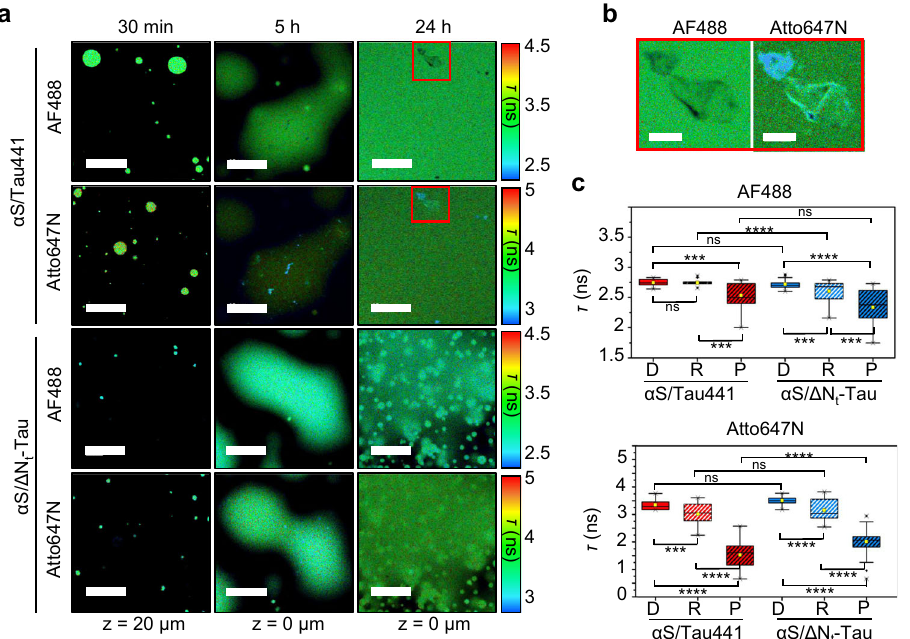
Fig. 6 | Analysis of the liquid-to-solid phase transition of α S/Tau coacervates. recorded for α S/Tau441 and α S/ Δ N t -Tau coacervate samples( N =17 – 32ROIs for D, a Fluorescence lifetime imaging microscopy (FLIM) images of α S/Tau441 and α S/ 29 – 44ROIsforRand21 – 51ROIsforpuncta).Meanandmedianvaluesareshownas μ M of each protein (1 μ M AF488-labeled α S and 1 μ M Atto647N- Δ N yellowsquaresandblacklineswithintheboxes,respectively.Lowerandupperbox t -Tau with 25 labeledTau441or Δ N t -Tau)inLLPSbuffer.Columnsshowrepresentativeimagesof limits indicate the fi rst and third quartile, respectively, while minimum and max- imum values within 1.5 × interquartile range (IQR) are shown as whiskers. Outliers the LLPS samples at different maturation times (30min, 5h and 24h). Red boxes are shown as black diamonds. The statistical signi fi cance between pairs of dis- show a region containing puncta for α S/Tau441. Lifetime range shown as a color tributions was determined with a two sample t -test assuming unequal variances. scale. Scale bar=20 μ m for all images. b Zoom-in FLIM image of the selected The p values from two-tailed t -test are shown as stars for each compared pair of regions shown in red boxes in panel a . Lifetime range shown with the same color data (* p value > 0.01, ** p value > 0.001, *** p value > 0.0001, **** p value > 0.00001), scaleasinpanel a .Scalebar=5 μ m. c Boxplotsshowingthelifetimedistributionsof AF488 (attached to α S) or Atto647N (attached to Tau) for the different protein ns means not signi fi cant ( p value > 0.05). Precise p values are provided in Supple- mentary Table 1 and source data as a Source Data fi species (droplets -D-, rafts -R- and puncta -P-) identi fi ed in the FLIM images